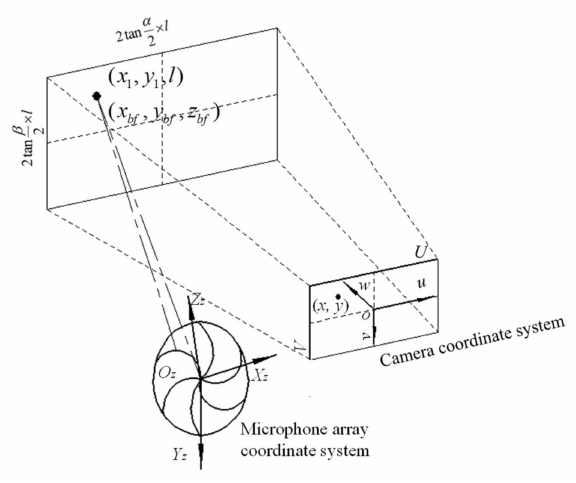
Figure 3. Relationship between array and stereo vision coordinate